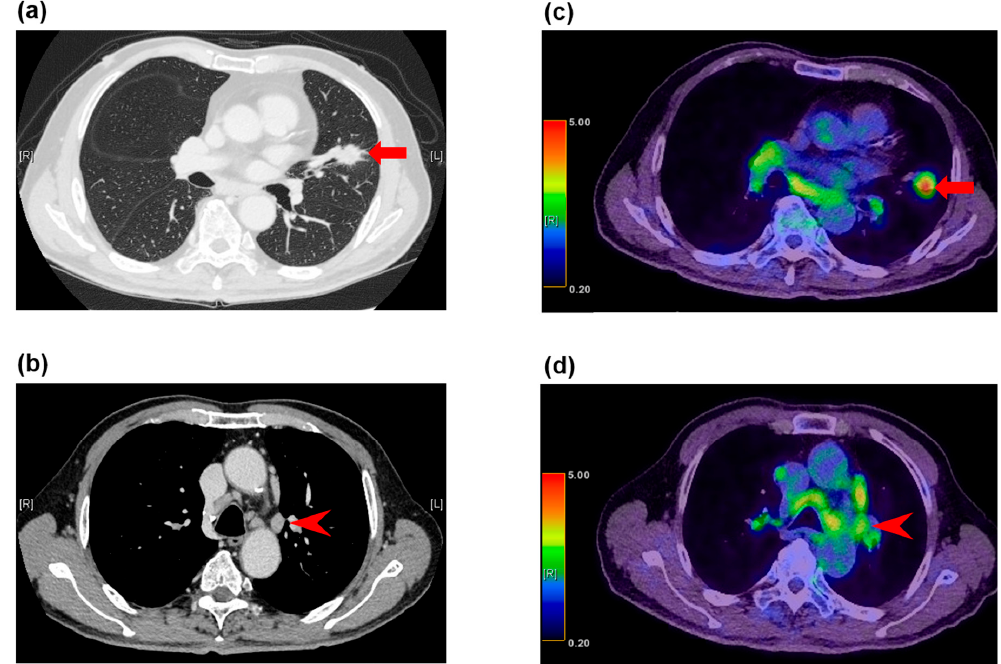
Figure 2. False positive FDG-PET/CT findings in enlarged lymph nodes in a 78-year-old man with squamous cell carcinoma. ( a ) The CT image shows a left upper lobe tumor (arrow), ( b ) and enlarged station 5 lymph nodes (arrowhead). ( c ) The FDG-PET/CT image shows FDG accumulation with a maximum SUV of 6.9 (arrow) in the squamous cell carcinoma in the left upper lobe, ( d ) and FDG accumulation with a maximum SUV of 3.9 in the enlarged station 5 lymph nodes (arrowhead). These lymph nodes demonstrated granulomatous inflammation at histopathologic examination of the specimen from surgical biopsy.